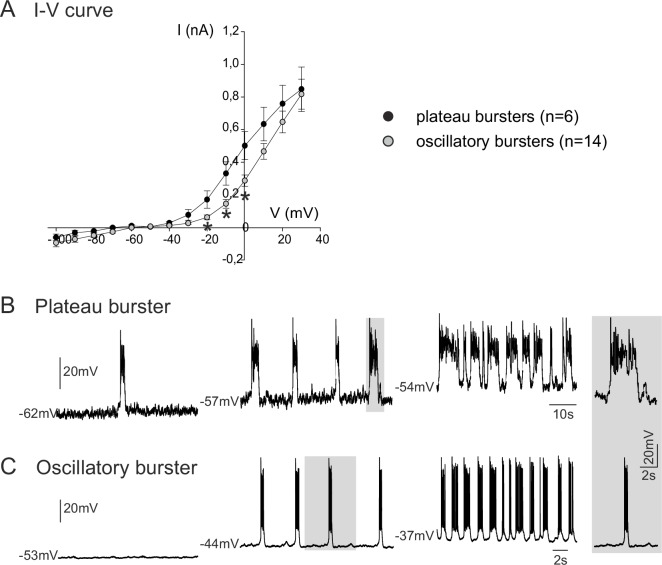
Voltage-dependence of pacemaker neuron properties.(A) Current-voltage (I-V) relationships for plateau (black circles) and oscillatory bursting (open circles) pacemaker neurons. Individual circles indicate mean (± SEM) current response to an injected step-change voltage pulse; n = number of neurons analyzed for each pacemaker phenotype. Asterisks indicate statistically different values (t-test; p<0.001). (B,C) Patch-clamp recordings of plateau (B) and oscillatory bursting (C) pacemaker neurons displaying cycle frequencies that varied with membrane voltage when held at different indicated membrane potential levels with continuous depolarizing current injection. Right inset: A single burst (indicated by shading) in each pacemaker neuron subtype displayed at the same time scale for burst duration comparison.